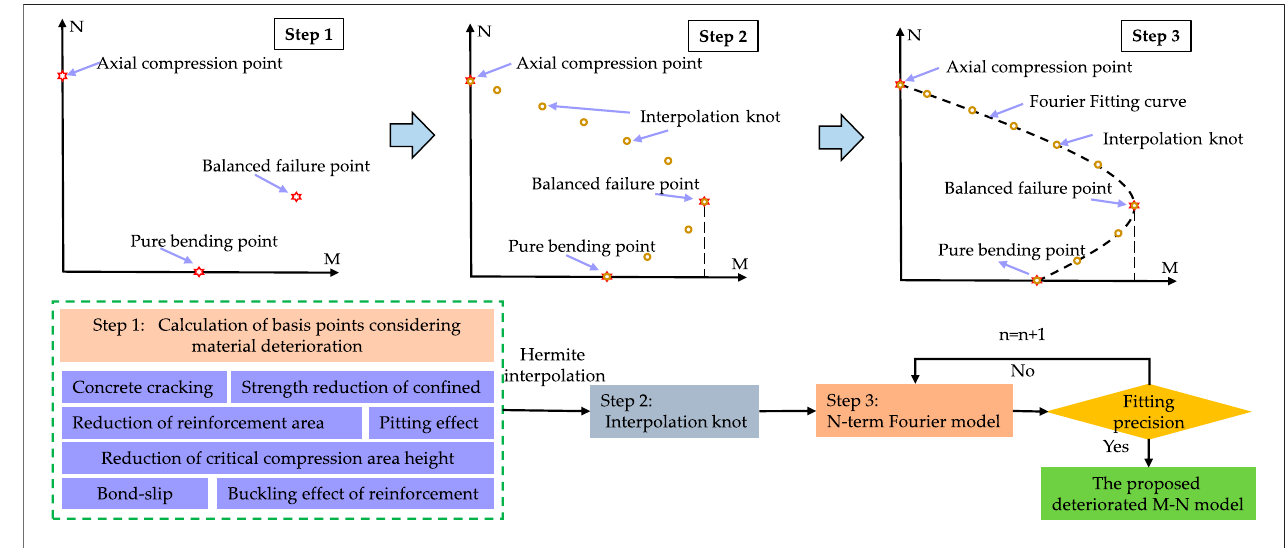
FIGURE 13 | Bearing capacity model considering section resistance degradation (Xin et al., 2019).